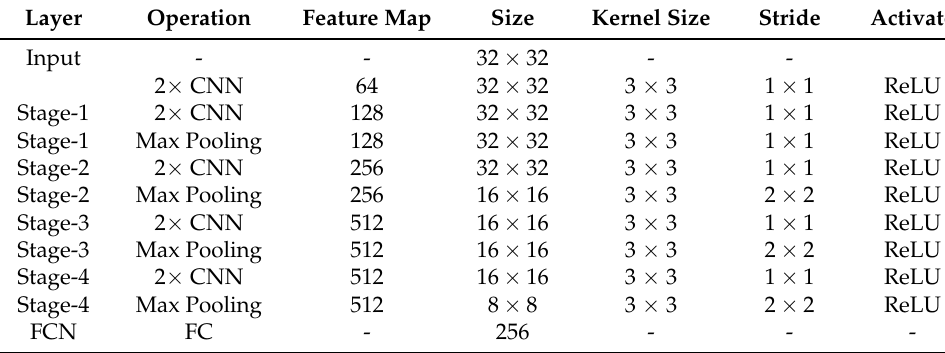
Figure 4. The proposed network structure. Table 1. Network structure